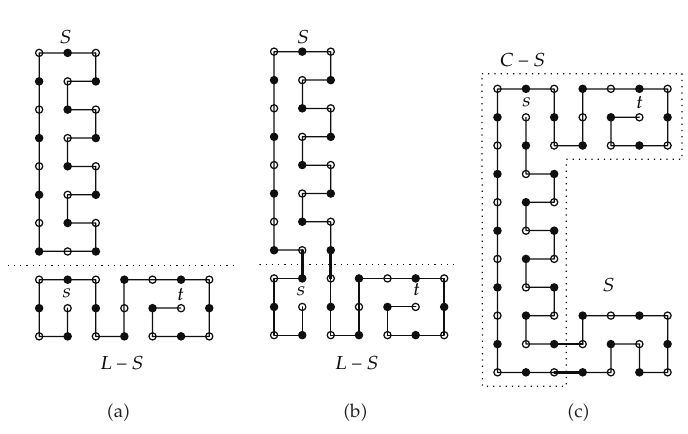
Figure 11: (cid:6) a (cid:7) , (cid:6) b (cid:7) A strip of L (cid:6) 3 , 3 (cid:7) , (cid:6) c (cid:7) a strip of C (cid:6) 3 , 3 (cid:7) .